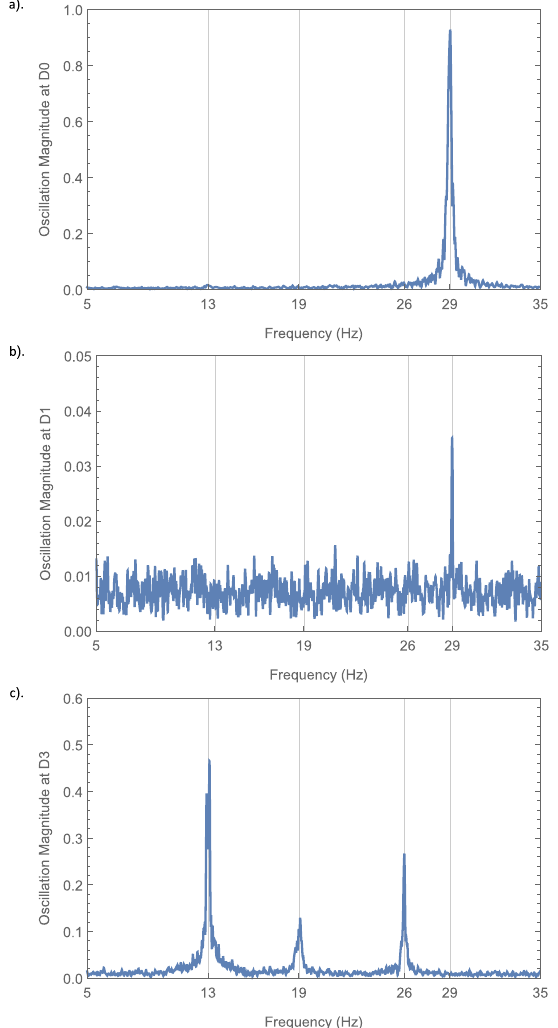
Fig. 3 Weak measurement tagging showing no weak trace from Bob ’ s mirrors at detector D 0 or D 1 . Fourier transform of position with respect to time, of light beam incident on detectors D 0 ( a ), D 1 ( b ) and D 3 ( c ). D 0 and D 1 show the oscillation from Alice ’ s mirror (at 29Hz), but unlike D 3 do not show the oscillations from Bob ’ s two mirrors (at 13Hz and 19Hz, with a second harmonic at 26Hz), proving via weak measurement that no light that goes to Bob ’ s mirrors ends up at either D 0 or D 1 .